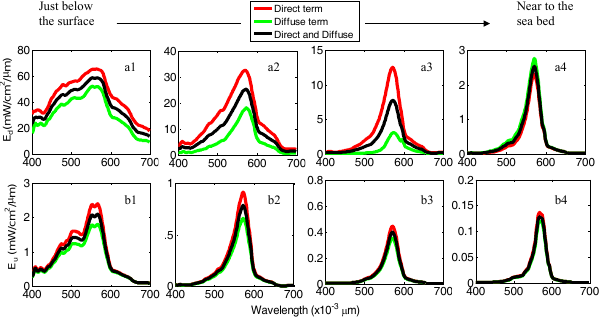
Figure 9. Spectral representation of the direct and diffuse terms of the underwater light fields for four discrete depths ( a1 – a4 for E d and b1 – b4 for E u ) in moderately turbid waters off Point Calimere. The red colour represents the direct term, the green colour indicates the diffuse term and the black colour represents the contribution of both direct and diffuse terms in the underwater light